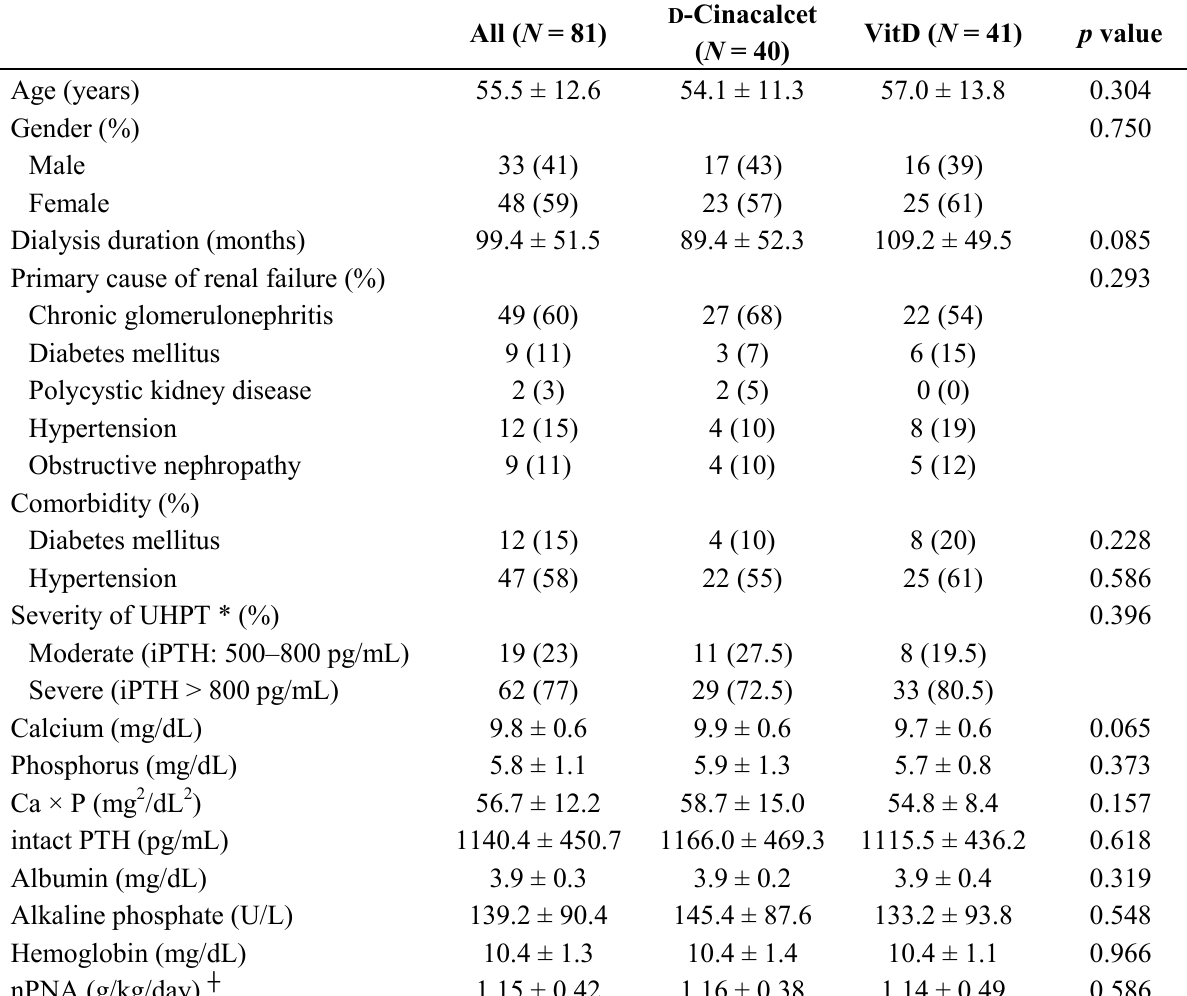
Table 1. Baseline demographic and biochemical data ( N =